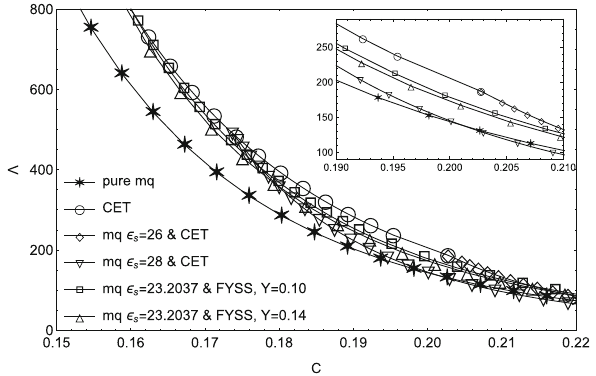
Fig. 3 Dimensionless tidal deformation (cid:2) versus compactness C = M / R of MQS/NS with MQ core